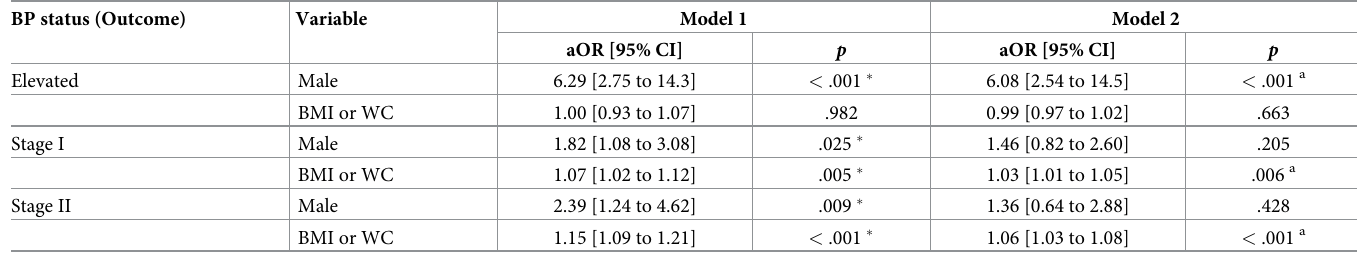
Table 3. Multinomial regression analyses of the associations of sex and anthropometric measurements with blood pressure status (n = 489).